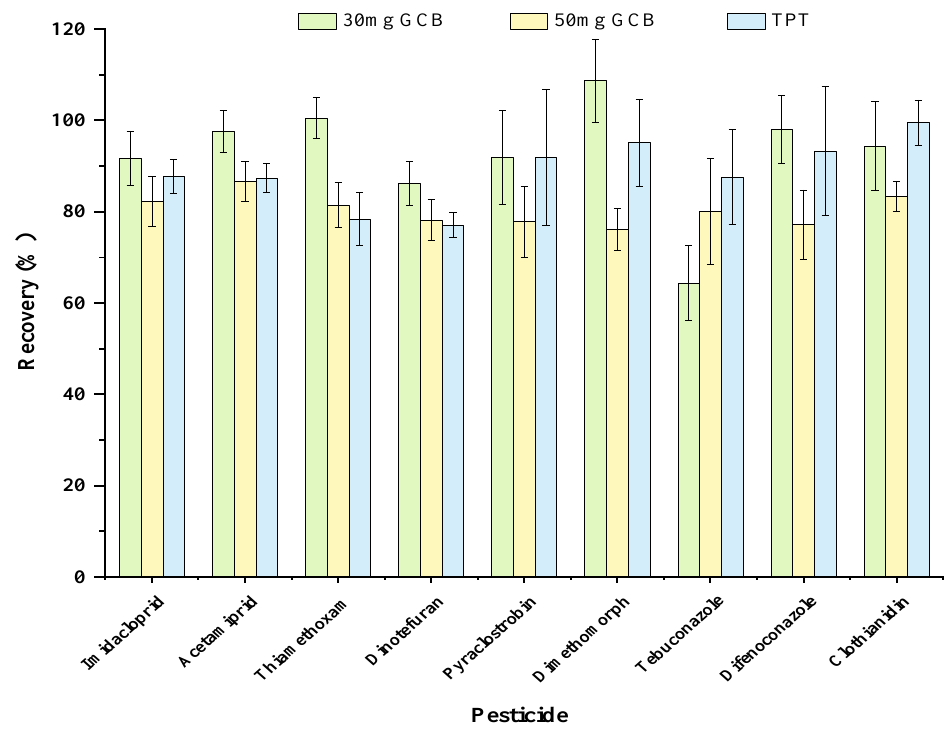
Figure 3. The recoveries of the LC-amenable pesticides with different clean-up procedures of TPT cartridge and a modified QuEChERS strategy.